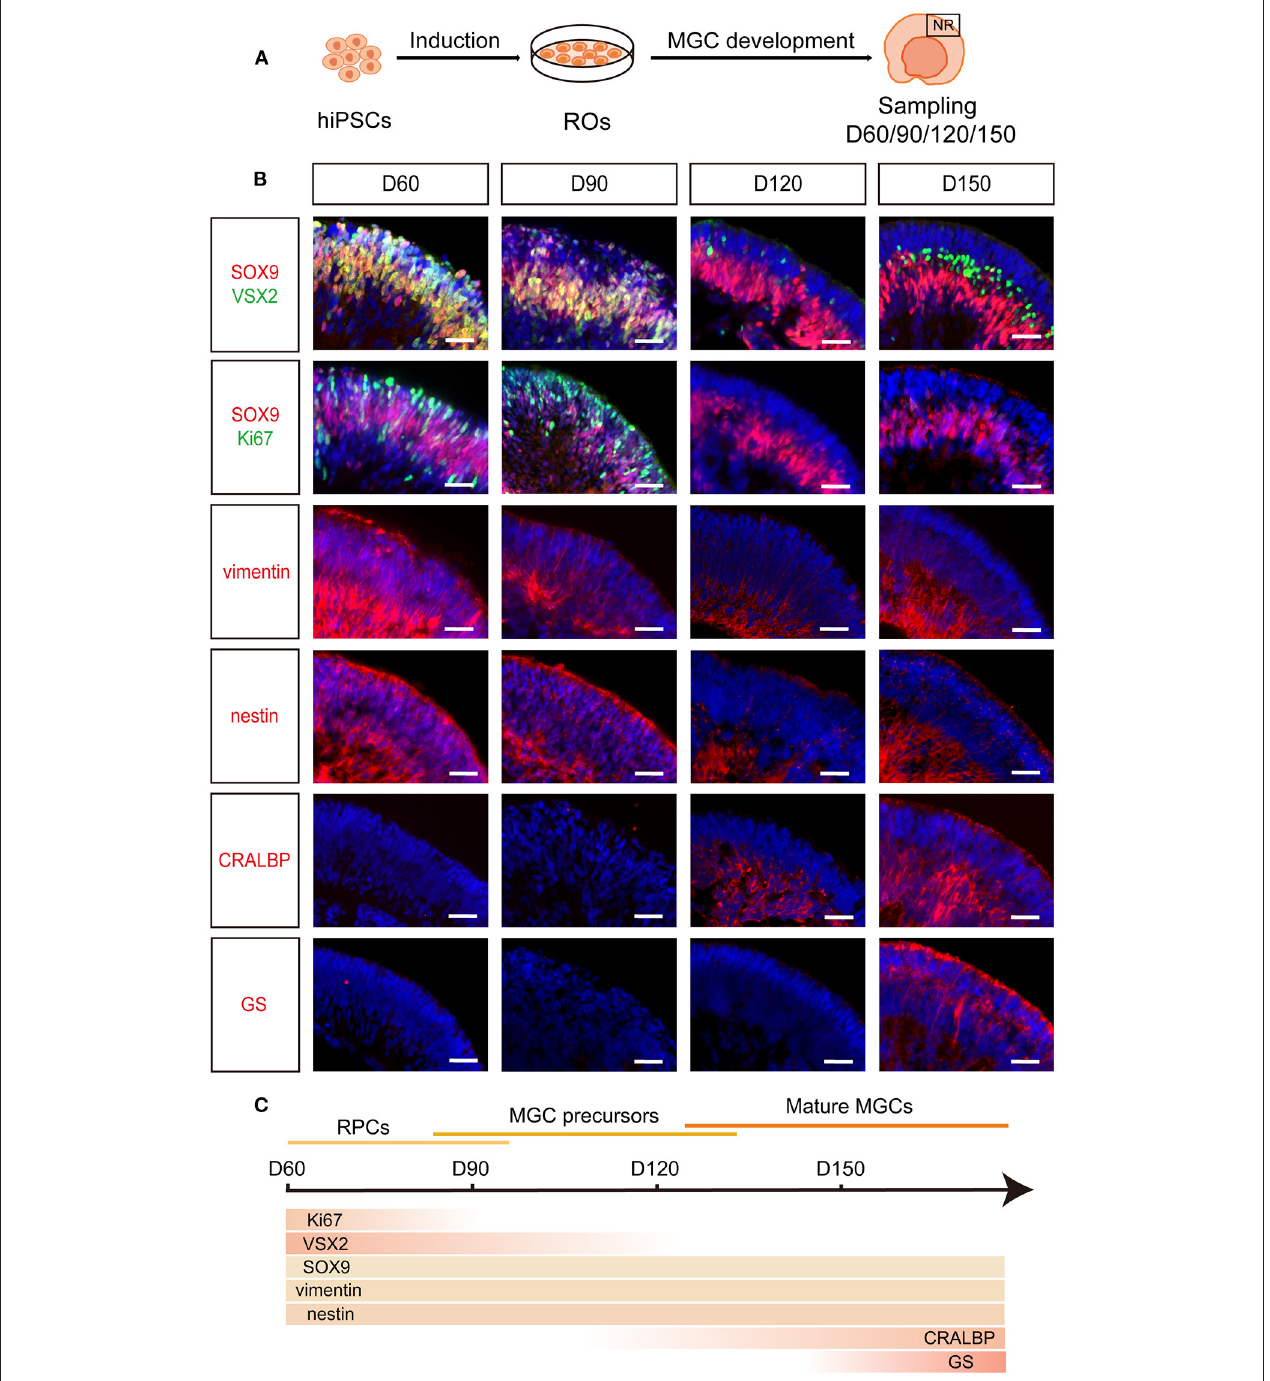
FIGURE 1 | Spatiotemporal development of MGCs in hiPSC-derived ROs. (A) Schematic overview of the development of MGCs in ROs. (B) Immunofluorescence staining showed the expression of markers VSX2, SOX9, Ki67, vimentin, nestin, CRALBP and GS in D60-, D90-, D120-, and D150-ROs. (C) Schematic diagram of MGCs development in hiPSC-derived ROs. hiPSC, human induced pluripotent stem cell; ROs, retinal organoids; MGC, Müller glial cell; NR, neural retina. Scale bars = 50 µ m (B) .